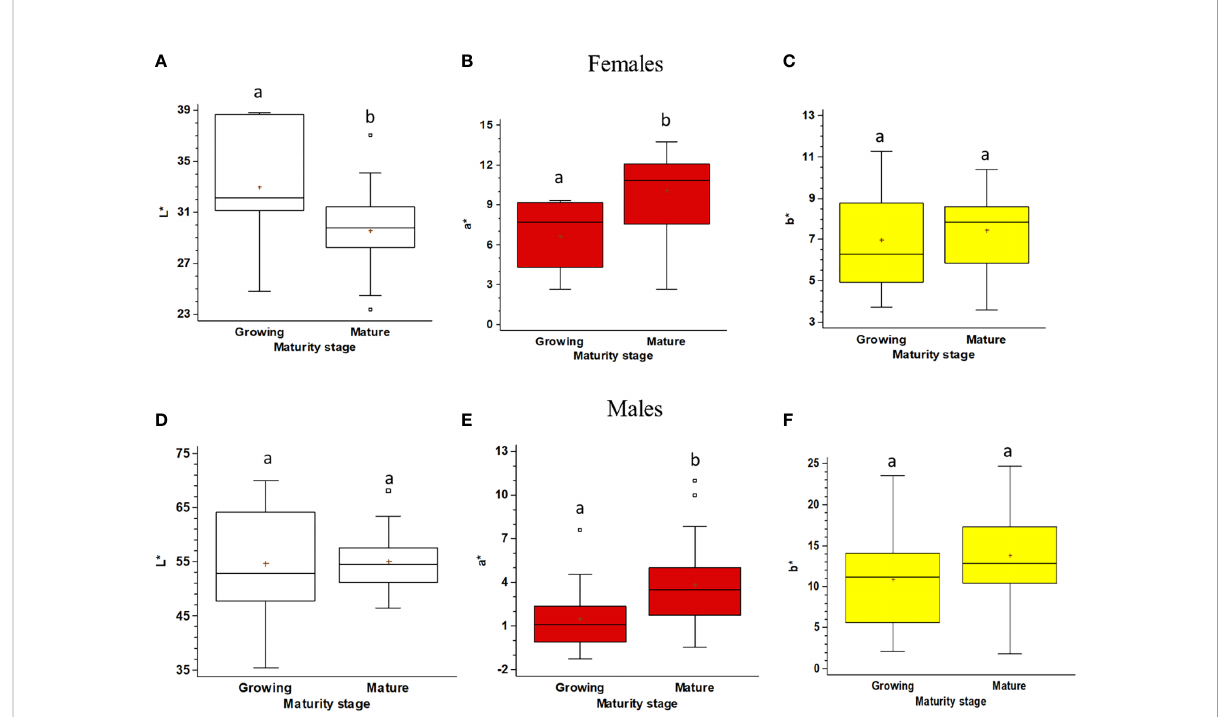
FIGURE 6 Boxplot of the color space (lightness, L*; redness, a*; yellowness, b*) of the gonads of Holothuria tubulosa, for females (A – C) and males (D – F) at Growing and Mature maturity stages. The boxes show the interquartile range, with the median value indicated by the horizontal line and the ‘ + ’ sign indicating the mean; whiskers show the range. Individual symbols show outliers. Lowercase letters indicate the results of the pairwise comparison of the L*a*b* value between Maturity stages.